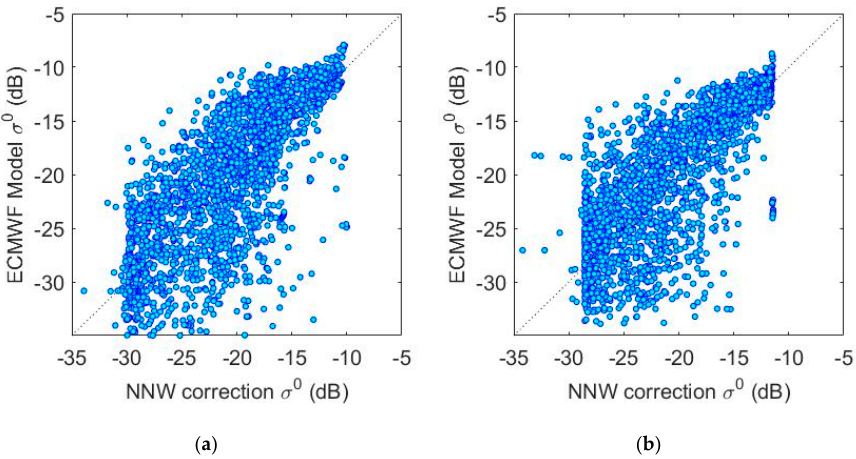
Figure 7. Scatter plot of NNW correction σ 0 and model σ 0 paired data with rainfall. ( a ) for HH polarization; ( b ) for VV polarization. The dashed line in this figure is the diagonal line.